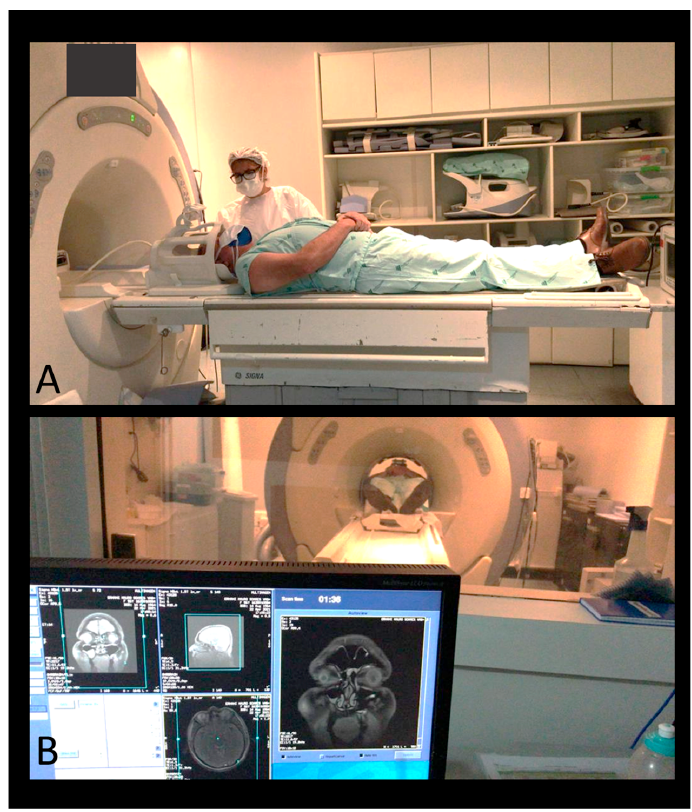
Figure 2. Moments during the performance of MRI on the brain of a patient with COVID ‐ 19 ( A ) Patient being positioned in the MRI machine with the brain coil having been placed. ( B ) Photograph of the MRI Control Room during the examination and the acquisition of the brain magnetic resonance images of a patient with COVID ‐ 19.